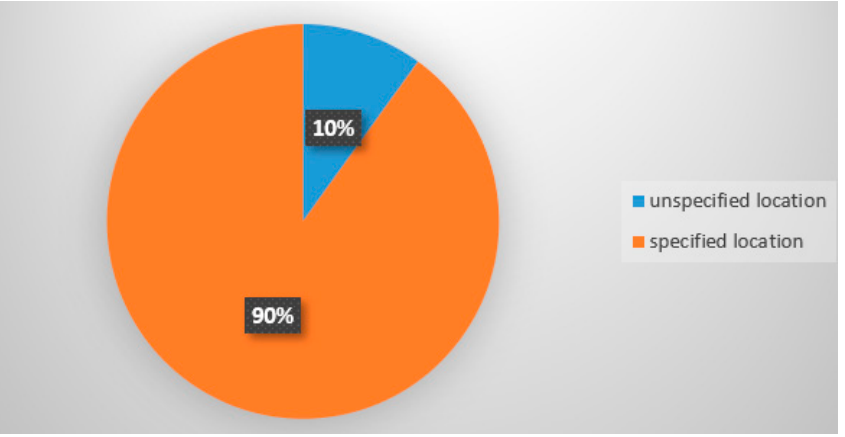
Figure 6. Specification of catch area on the product label.